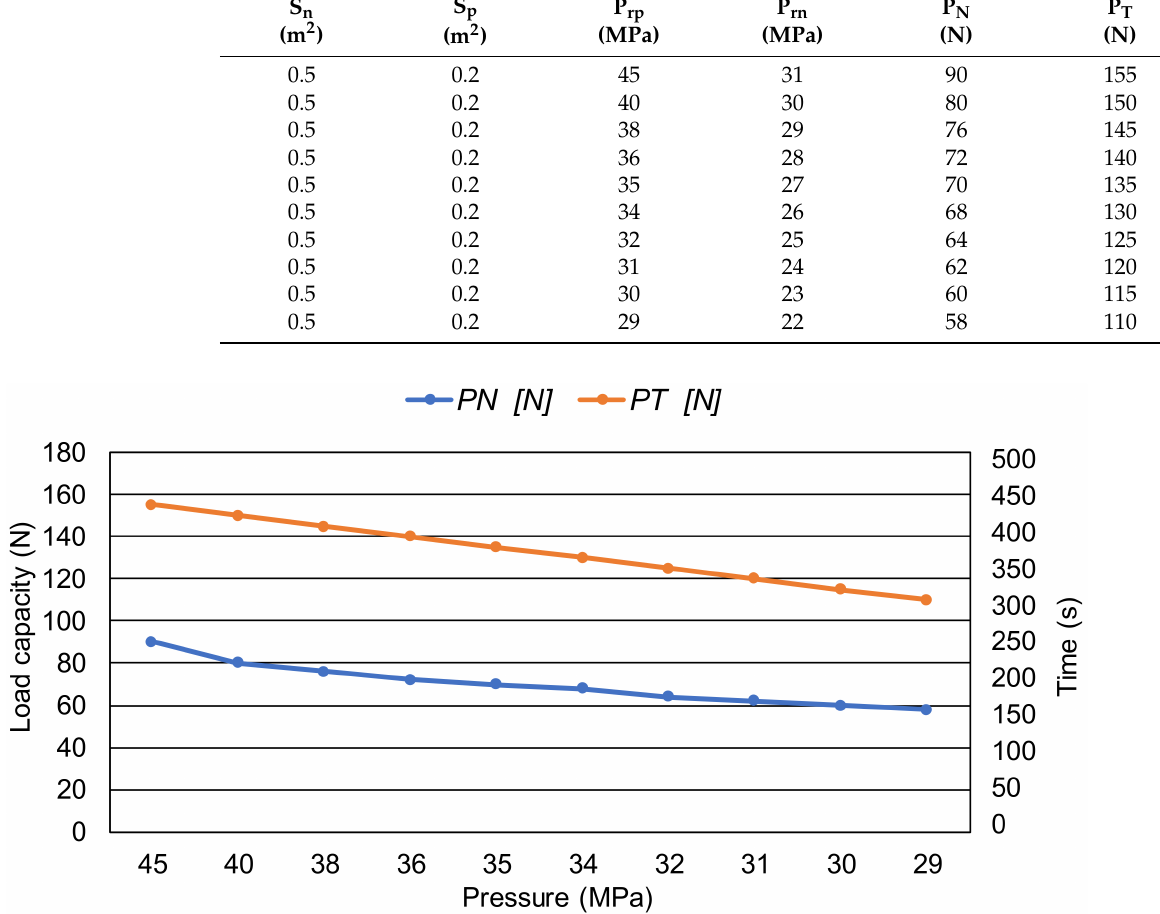
Table 2. The results of the operation of the canopy support actuator in the longwall.